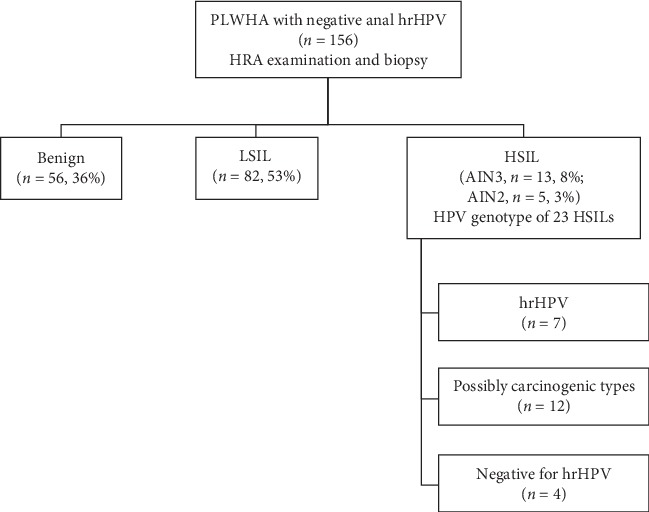
Study flow chart.